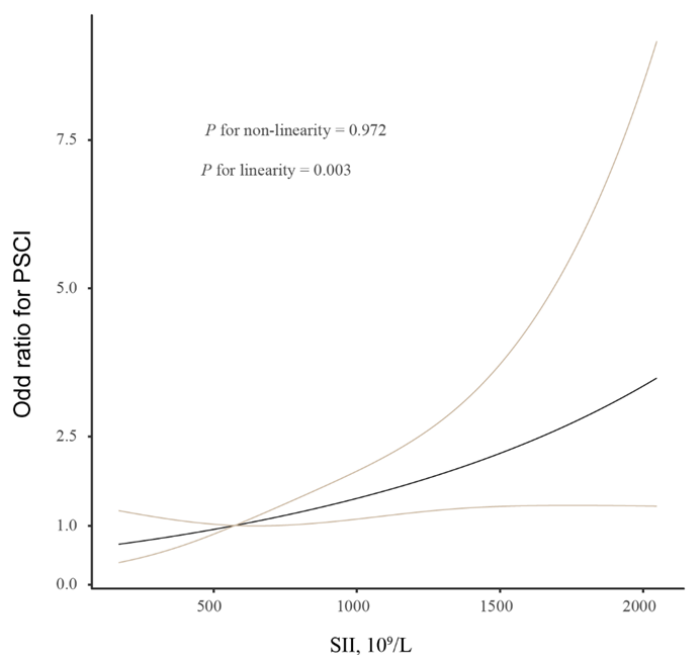
Figure 1. Restricted cubic spline evaluated the association between SII index and PSCI. Association was fitted with restricted cubic spline with 3 knots (at 5th, 50th, and 95th percentiles) controlling for demographic characteristics, education years, hypertension, diabetes, stroke subtypes, baseline NIHSS score, and Hs-CRP levels. The midpoint of SII index was set as the reference point. Abbreviations: PSCI, post-stroke cognitive impairment; SII, systemic